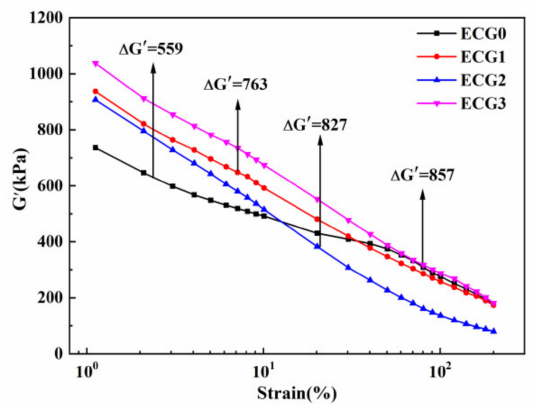
Figure 3. Storage modulus versus strain of CNT/GNP/EUG composites.